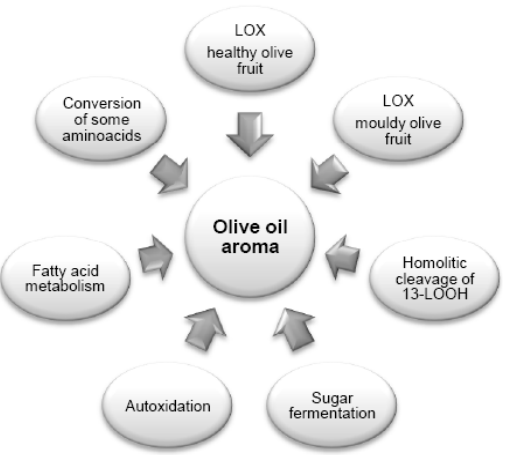
Figure 1. The main pathways involved in the formation of volatile compounds in VOOs.